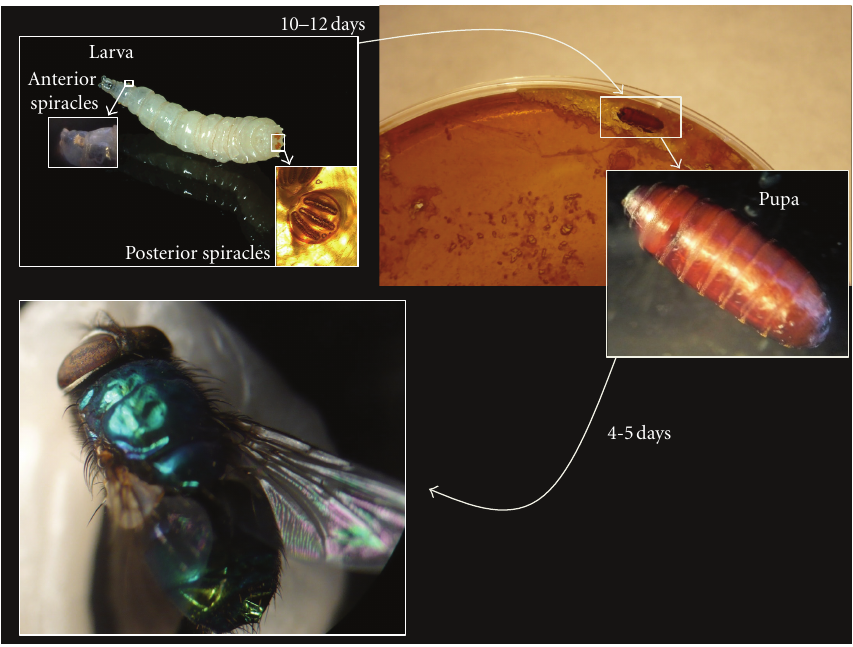
Figure 1: Aspect and evolution of the larvae of Lucilia sericata in our laboratory. Box picture of the posterior spiracles viewed under a microscope at low